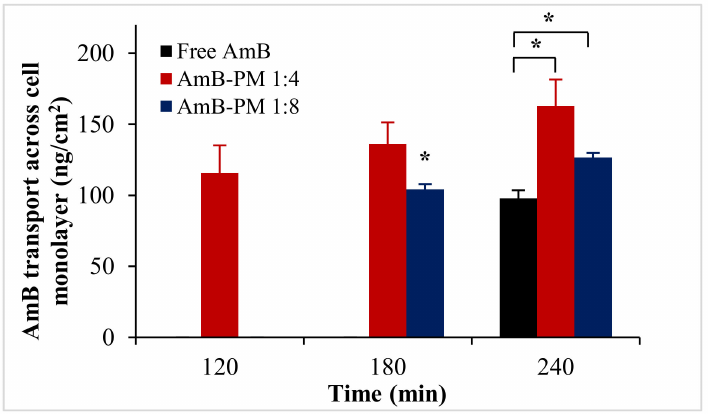
Figure 6. AmB transport across Caco-2 cell monolayer after incubation with AmB-PM and free drug. Data are presented as mean ± SD, ( n = 3). * indicate statistically significant di ff erences between formulations ( p < 0.05).